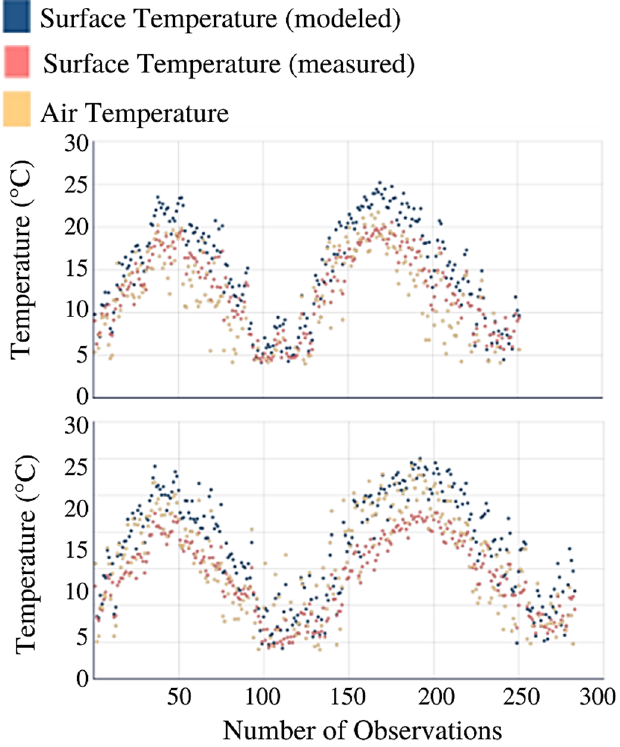
Figure 2. Scatter plot of the temporal variation of the modeled surface temperature, measured surface temperature and air temperature. The upper and lower plots represent temperature values corresponding to the AM and PM overpasses, respectively.